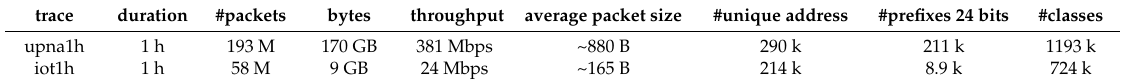
Table 2. Global statistics from the evaluation traffic traces.